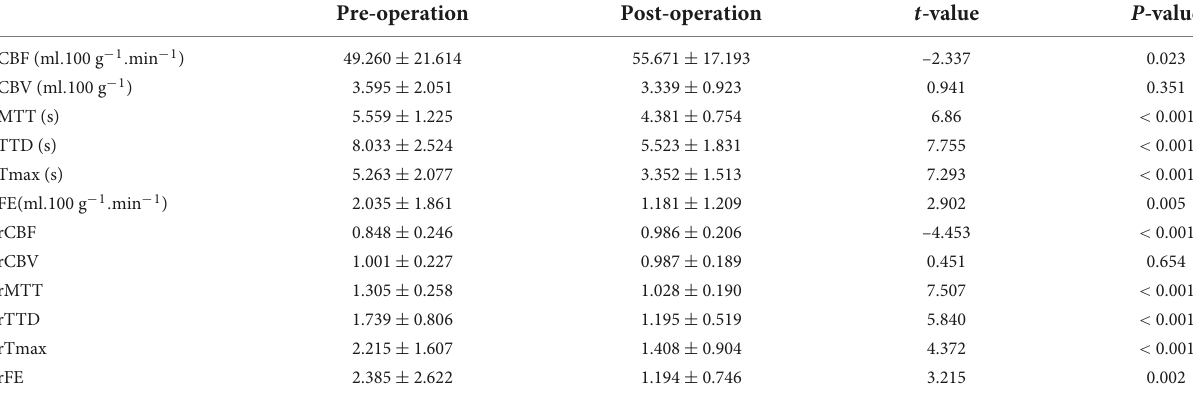
TABLE 2 Comparison of CTP values of surgical side before and after operation (mean ± SD). Pre-operation Post-operation